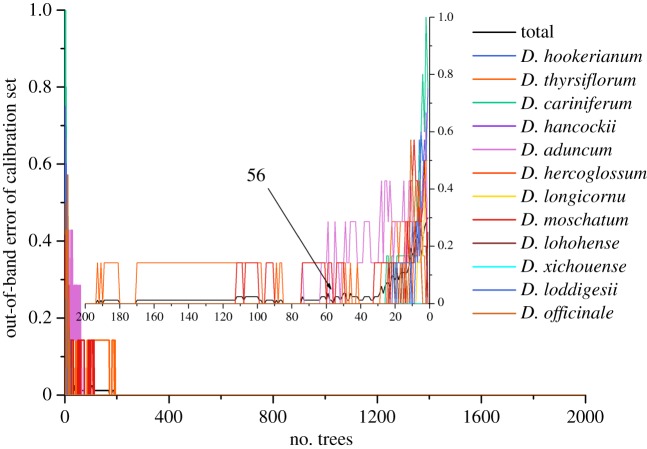
The selection results of ntree using the low-level fusion strategy.